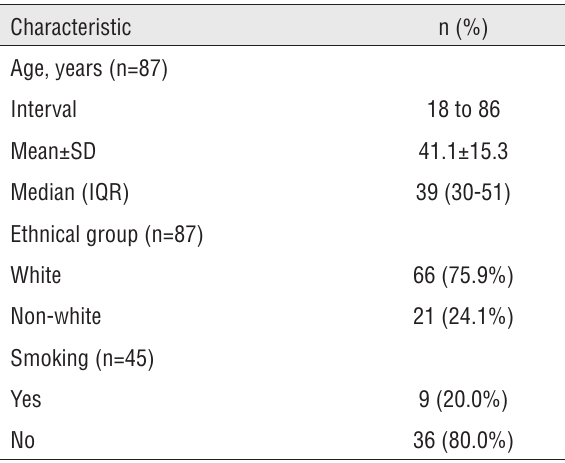
Table 2 - Demographic characteristic of non-Indians